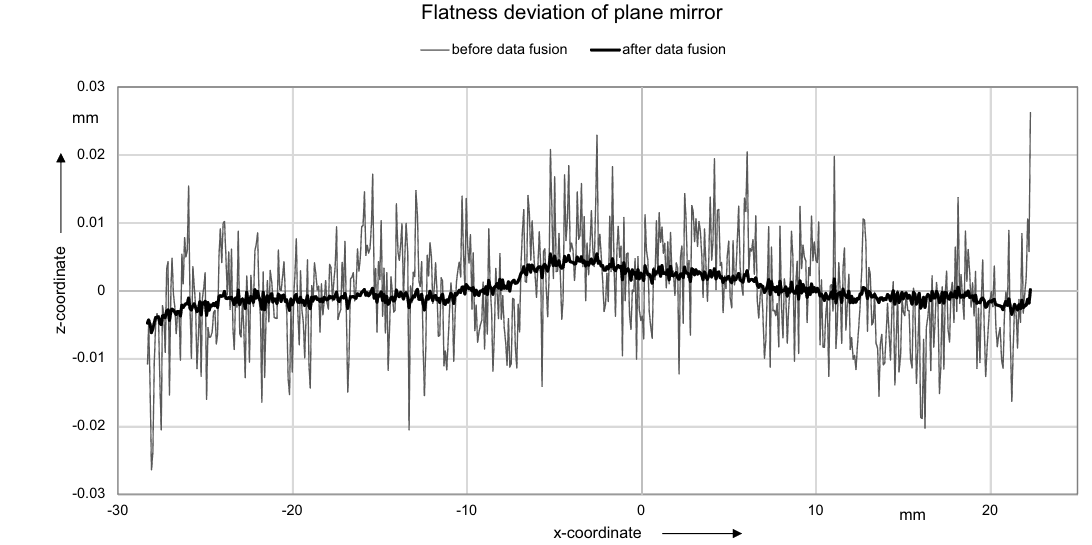
Figure 9. Flatness deviation of one row of the plane mirror before and after data fusion.